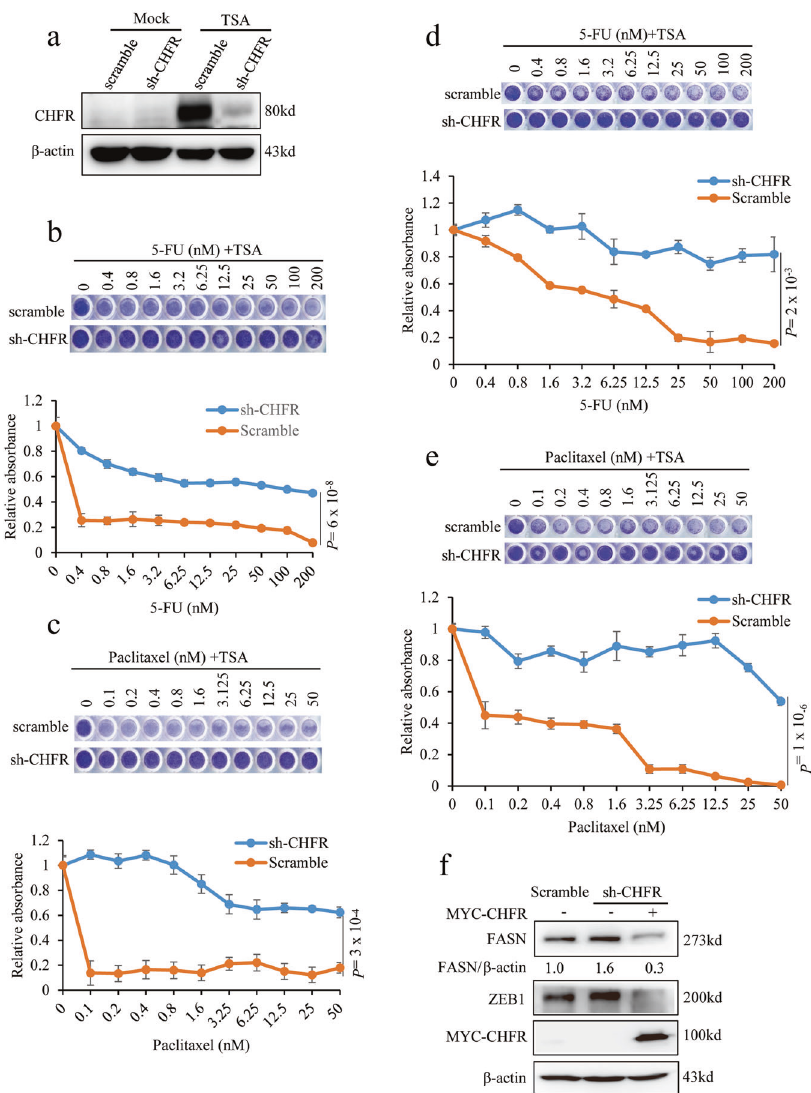
Fig. 6 TSA suppresses chemoresistance through CHFR. a CHFR was stably knocked down in LM2 cells and treated with or without 0.6 μ M TSA and immunoblotted with the CHFR and β -actin antibodies. b , c Scramble and sh-CHFR stable LM2 cells as described in a were co-treated with 0.6 μ M TSA and the chemotherapy drugs 5-FU ( b ) or paclitaxel ( c ) for 36 h. After fi xing with 10% methanol, the cells were then stained with 1:1000 crystal violet. d , e Scramble and sh-CHFR stable MDA-MB-231 cells were treated and analyzed as described in b , c . f LM2 cells that stably knocked down CHFR were rescued with or without MYC-CHFR and immunoblotted with the FASN, ZEB1, MYC, and β -actin antibodies. Signi fi cance of scramble versus sh-CHFR is shown. n = 3 wells per group. Data in b – e are the mean of biological replicates from a representative experiment, and error bars indicate s.e.m. Statistical signi fi cance was determined by a two-tailed, unpaired Student ’ s t test. The experiments were repeated three